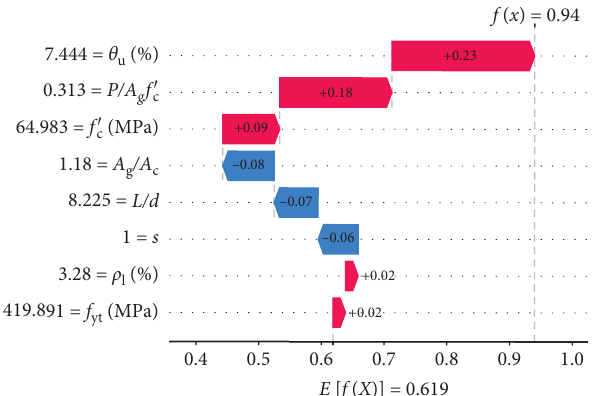
Figure 6: Individual interpretation for a typical circular sample.